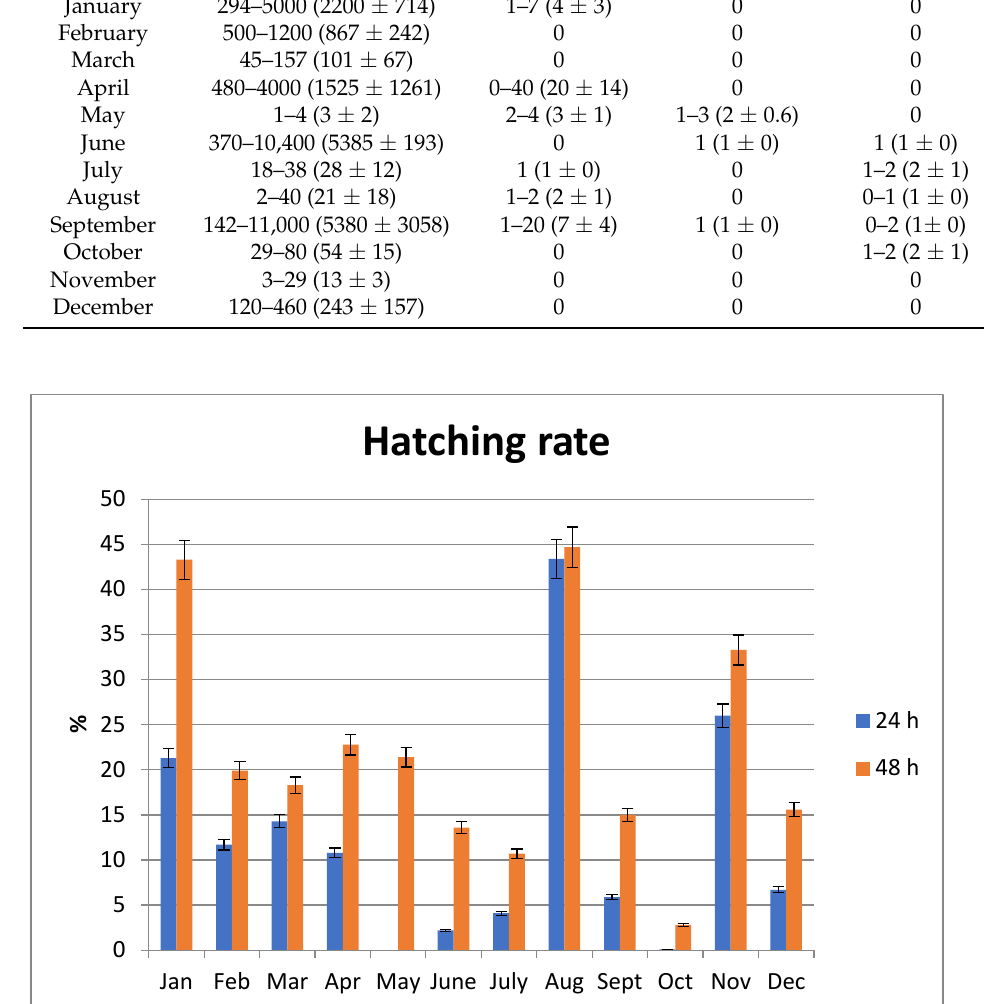
Figure 13. Seasonal dynamics of Artemia nauplia hatching rate, % (mean ± SD of three to five de- terminations).